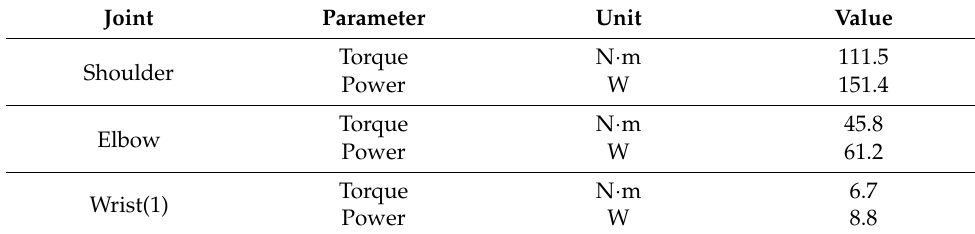
Figure 9. Required power for each joint. Table 3. Calculated Torque and Power for Smart Actuators in Each